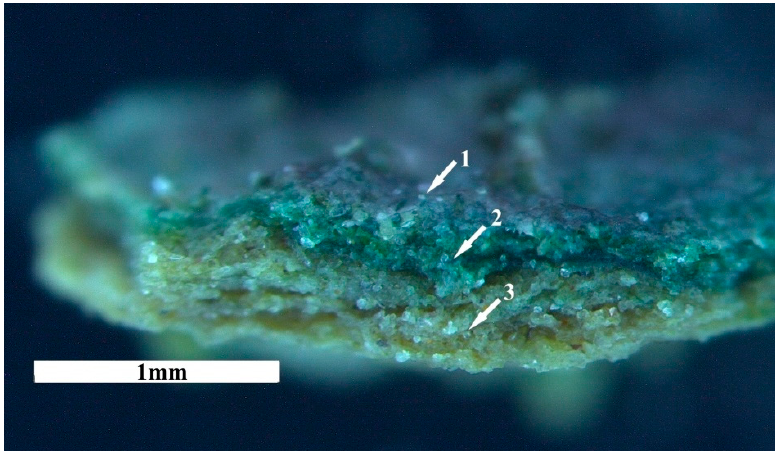
Figure 7. Cross-section of a biocrust sample. There were three layers within the biocrust: one show- ing trapping particles by superficial cyanobacterial colonies (arrow 1), another showing particle accumulation in the cyanobacterial organic layer (arrow 2), and a third one showing deposition of particles below the cyanobacterial biofilm as a result of the migration of cyanobacteria to the upper layers (arrow 3).